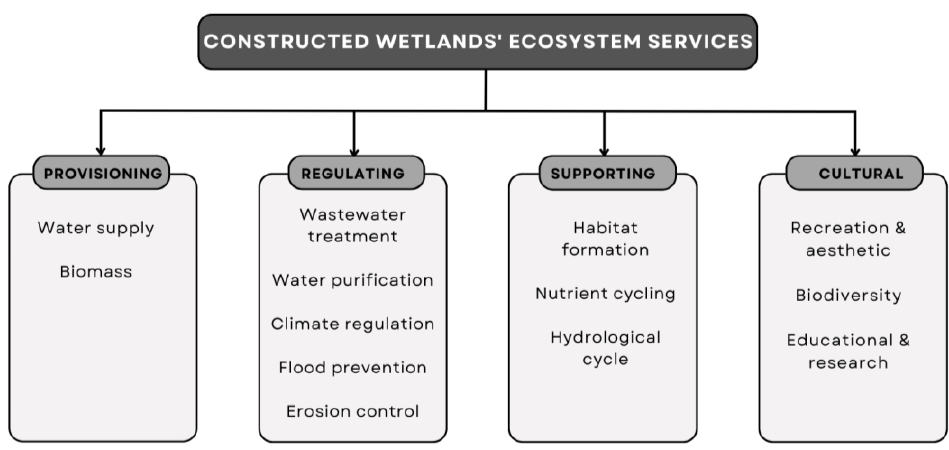
Figure 2. Summary of ecosystem services of constructed wetlands for wastewater treatment.